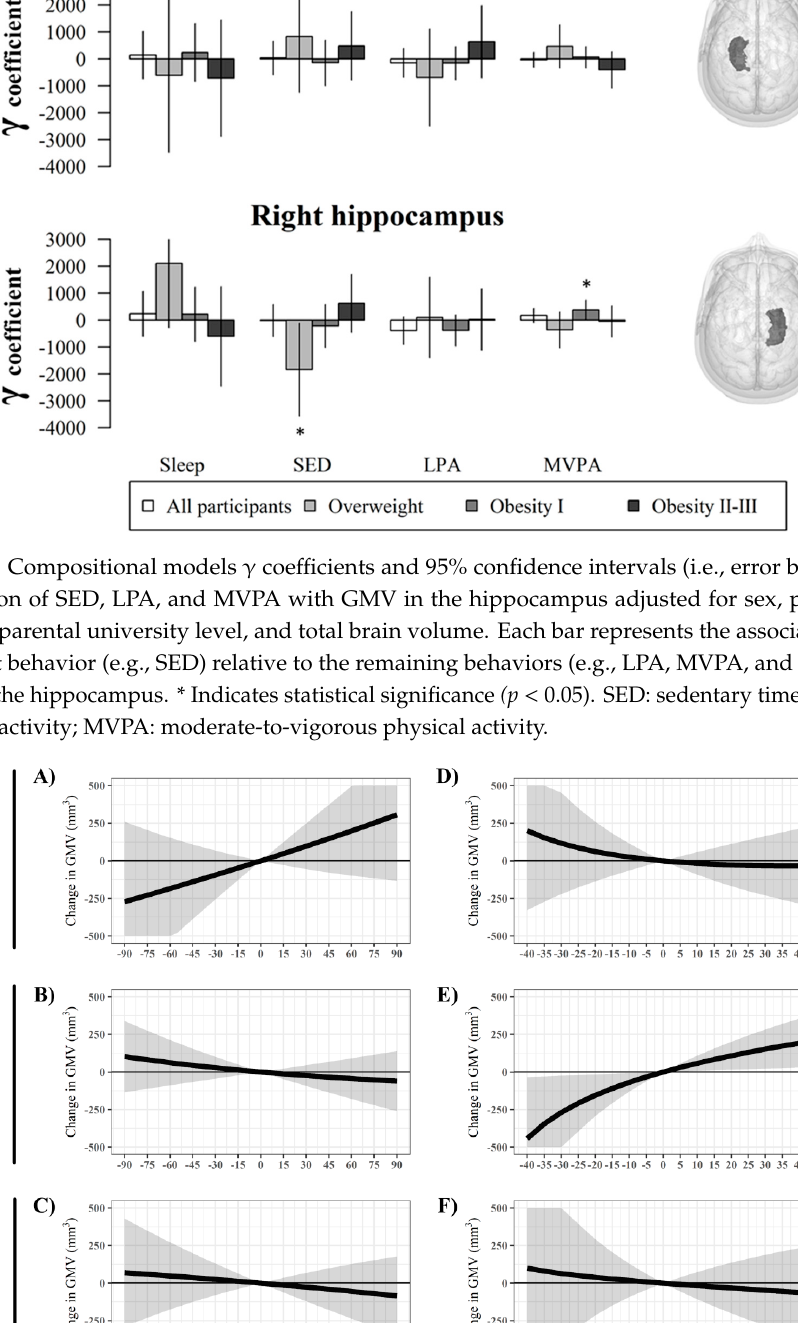
Figure 3. Effect of reallocating time from SED to LPA (Panels A , B , and C ) and to MVPA (Panels D , E , and F ) on the association with gray matter volume in the right hippocampus using compositional models. SED: sedentary time; LPA: light physical activity; MVPA: moderate-to-vigorous physical activity.